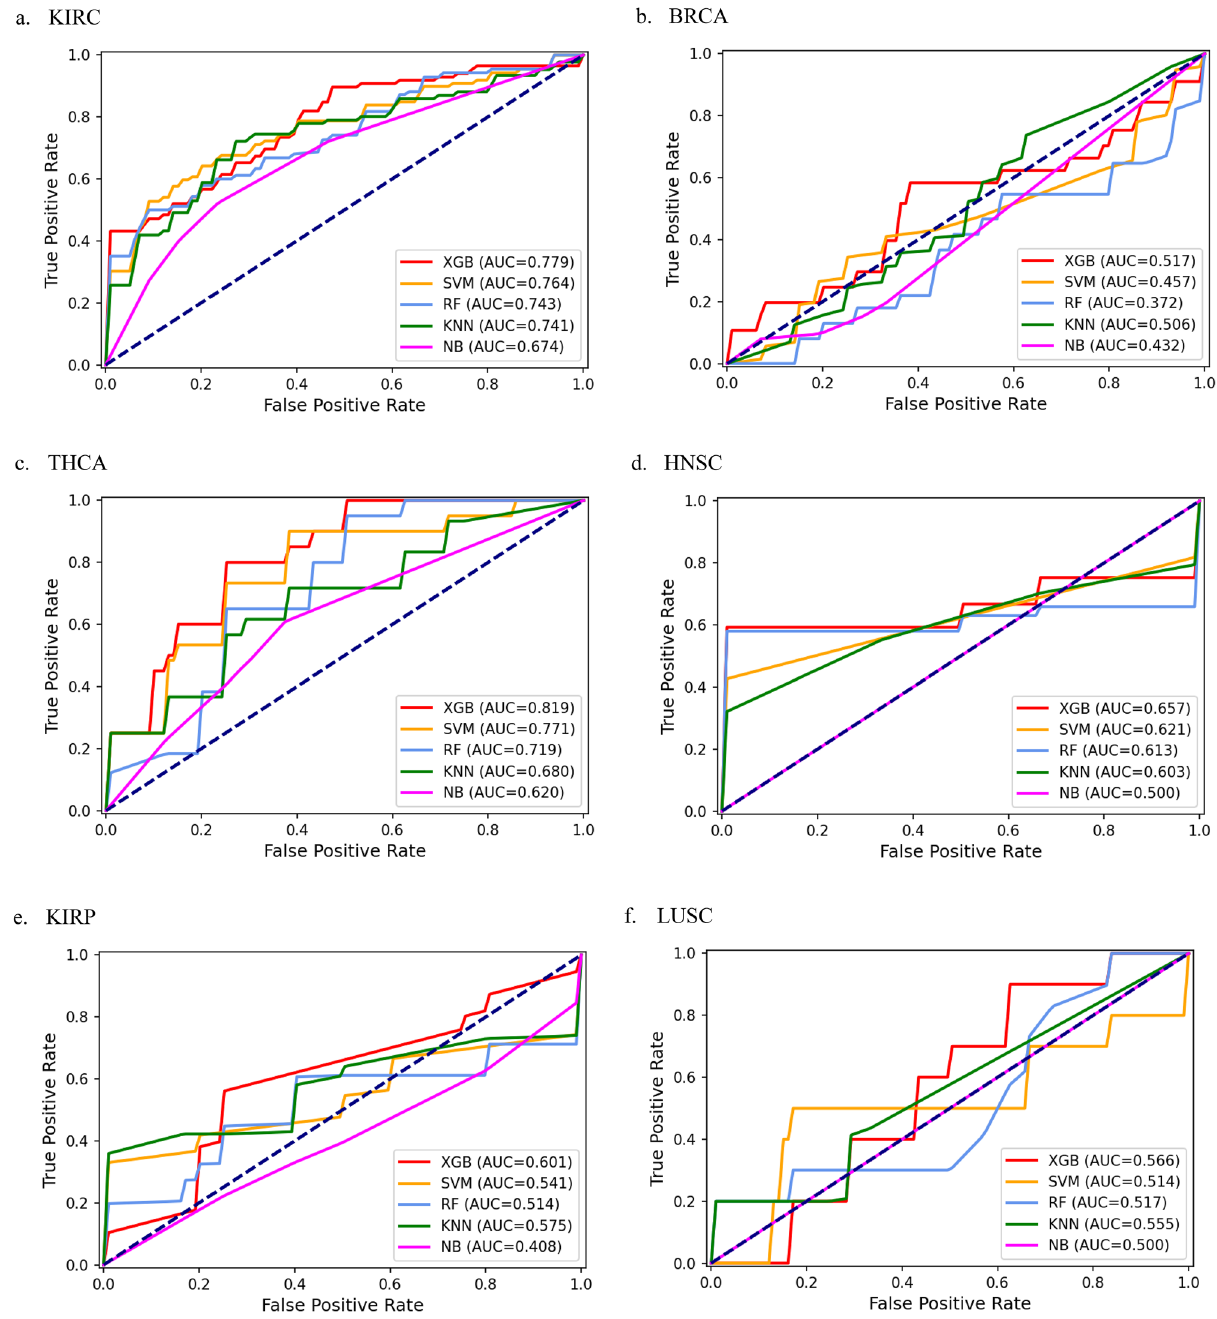
Figure 1. The ROC curves of XGBoost, SVM, RF, KNN and NB on nine datasets. ( a ) KIRC, ( b ) BRCA, ( c ) THCA, ( d ) HNSC, ( e ) KIRP, ( f ) LUSC, ( g ) LIHC, ( h ) COAD, ( i )